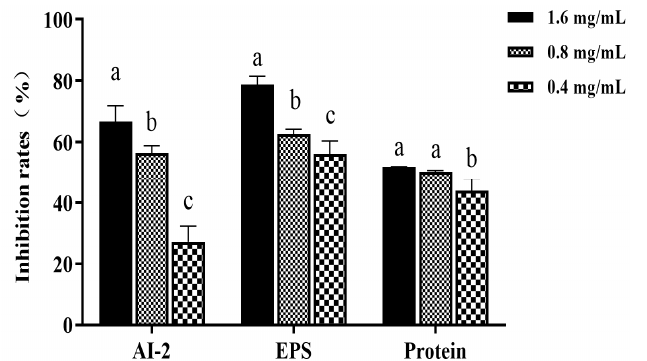
Figure 5. The effect of Z057-E on AI-2 activity, EPS, and extracellular protein synthesis of V. parahaemolyticus . Significant differences ( p < 0.05) are indicated by different letters (a, b, and c).